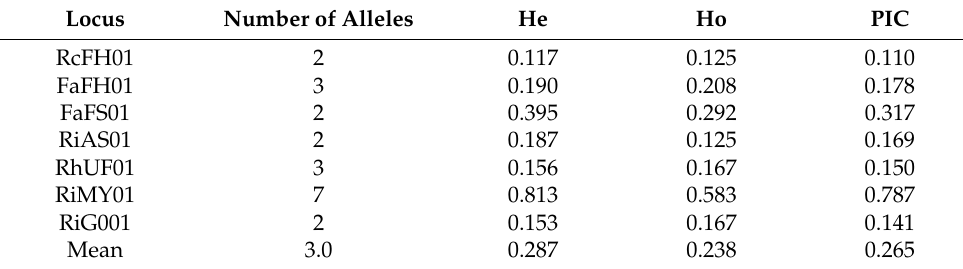
Table 6. Parameters of genetic variation of red raspberry